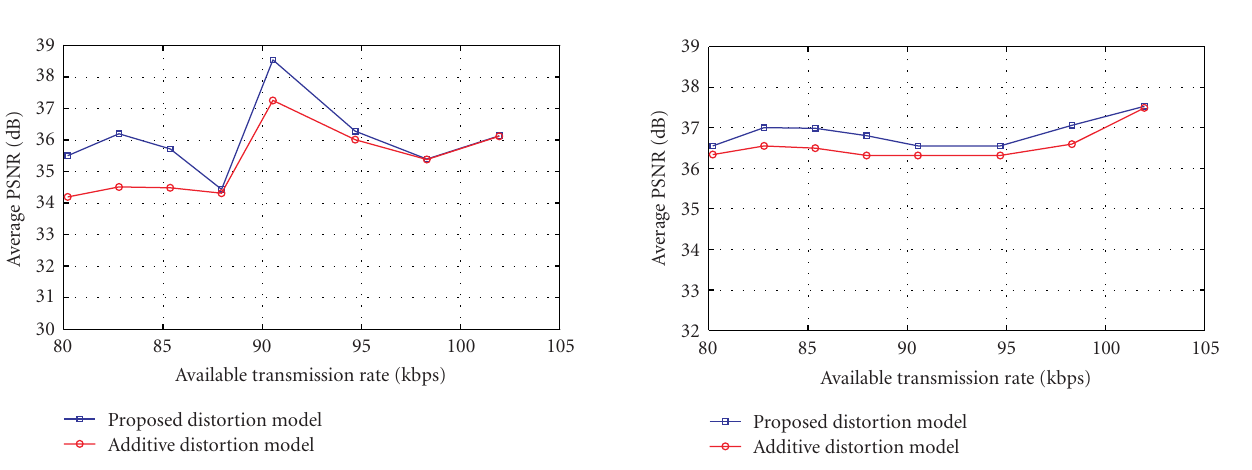
Figure 7: Average PSNR (in dB) as a function of available trans- mission rate (in kbps) for the “greedy-loss distribution” algorithm. Comparison between the proposed and the simplified “additive” distortion model for the video sequence Salesman